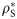
Comparison of the simulation results from mean-field approximation (MA), pair approximation (PA) and Monte Carlo simulation (MCS), depending on mortality cost and growth rate; (a). βS = 10, (b). βS = 30, (c). mI = 15.(i) equilibrium density of healthy individuals (ρS*) (ii) equilibrium density of infected individuals (ρI*). The dots, solid line and dashed line indicate the results of MA, PA and MCS, respectively. These results show that when mI is low, both approximation methods present similar trend to MCS, although these methods overestimate the equilibrium value. (iii) The variance among 100 trials in MCS. A high variance means the oscillatory solution is observed.